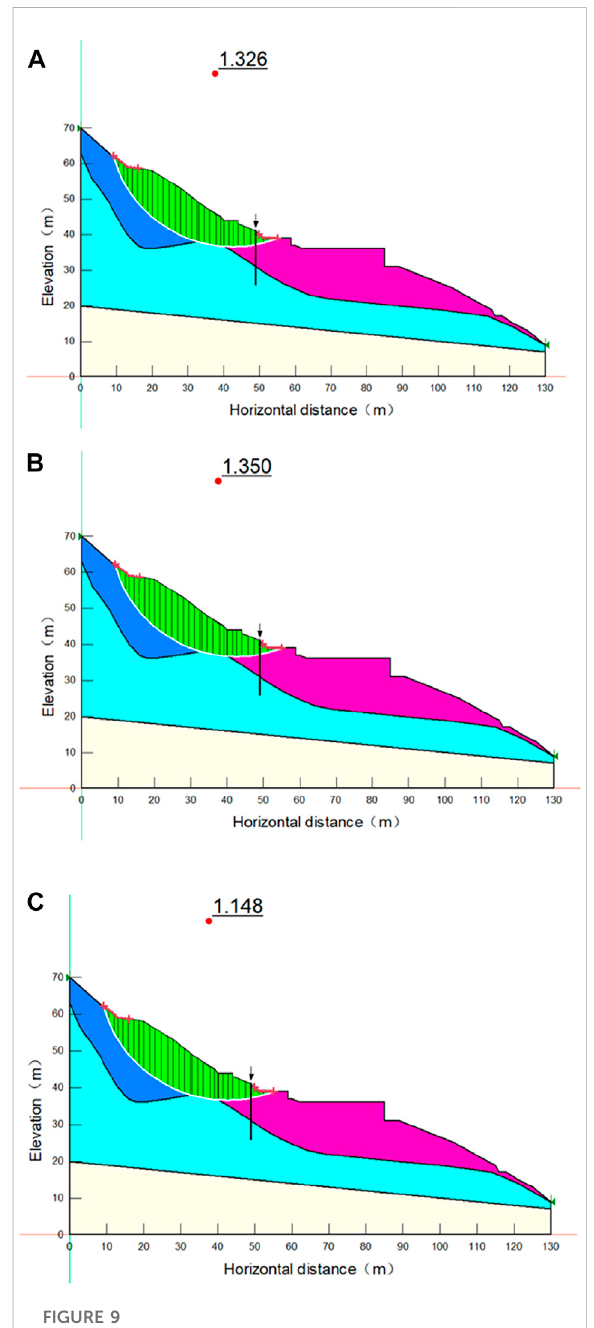
Numerical simulation results after treatment (The black line crossingthestratuminthe fi